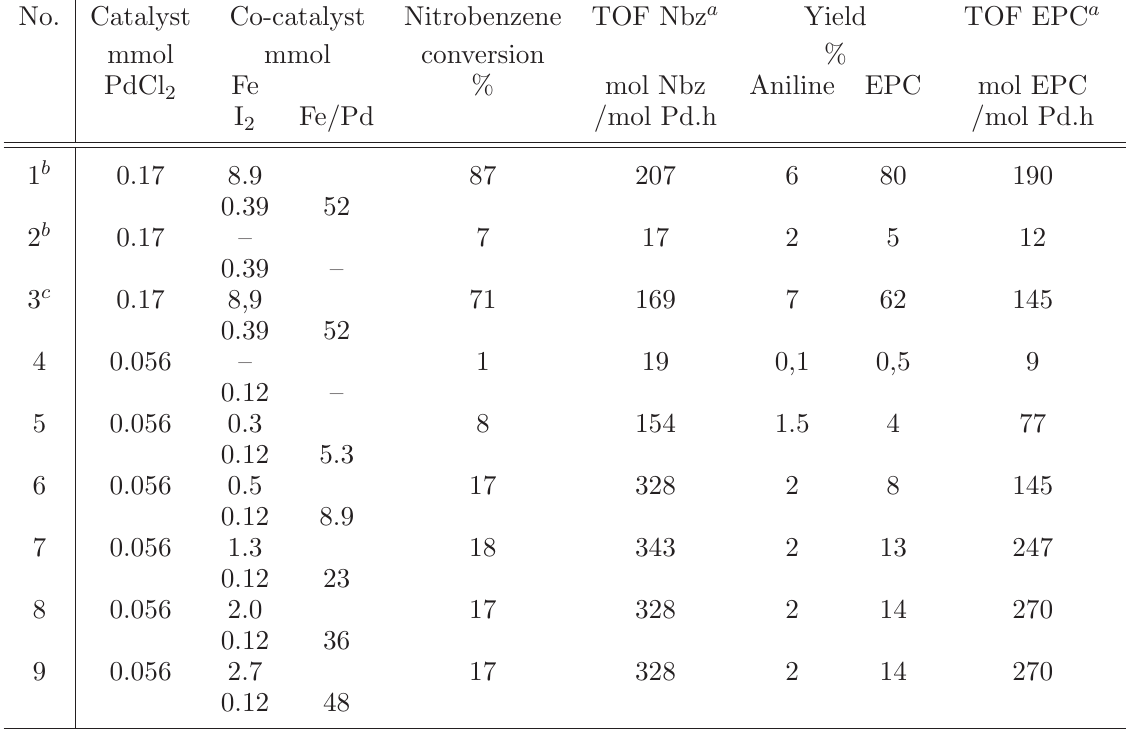
Table 2 The effect of the amount of iron on reductive nitrobenzene carbonylation at a constant PdCl 2 /I 2 /Py